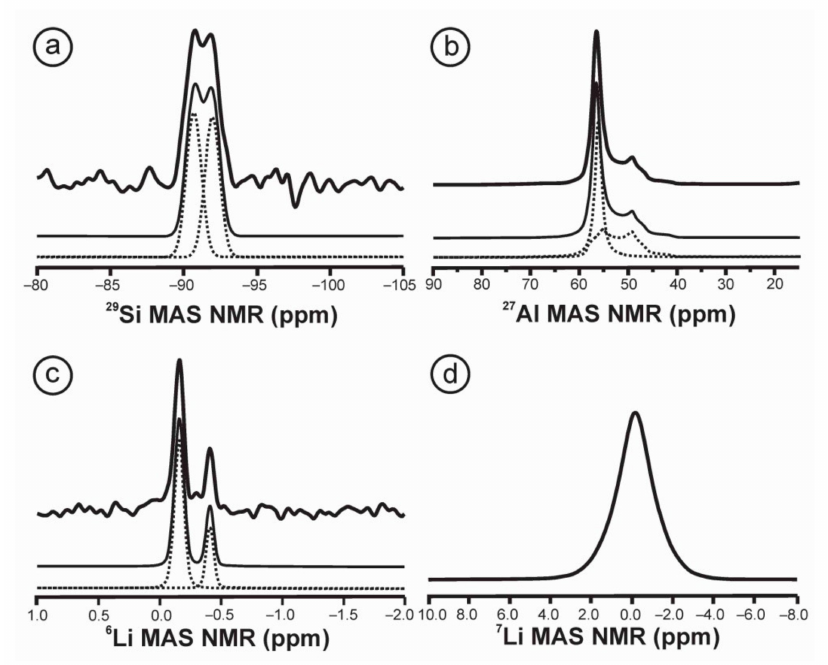
Figure 9. The 29 Si, 27 Al, 6 Li, and 7 Li MAS NMR spectra of ordered β -eucryptite LiAlSiO 4 from crystallization at 900 ◦ C and 3 kbars in hydrothermal conditions. ( a ) The 29 Si spectrum have two signals with the same area, as also occurs in the 27 Al ( b ), but having very different quadrupolar parameters. ( c ) The 6 Lispectra consist of two resonances, the largest with an area three times greater than the smallest. ( d ) The 7 Li spectrum only allows resolving a single site (Table 3). NMR parameters of the spectra are described in the